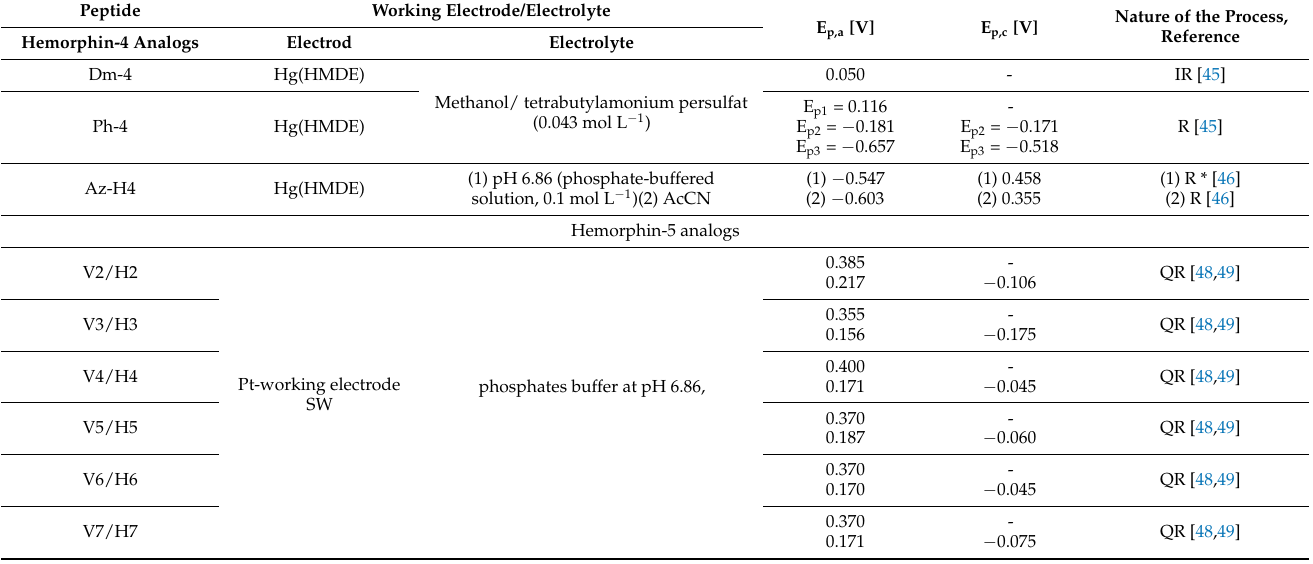
Table 7. Parameters of the voltammetric measurements and the electrochemical data of peptides. Peptide Working Electrode/Electrolyte Nature of the Process, E p,a [V] E p,c [V] ReferenceHemorphin-4 Analogs Electrod